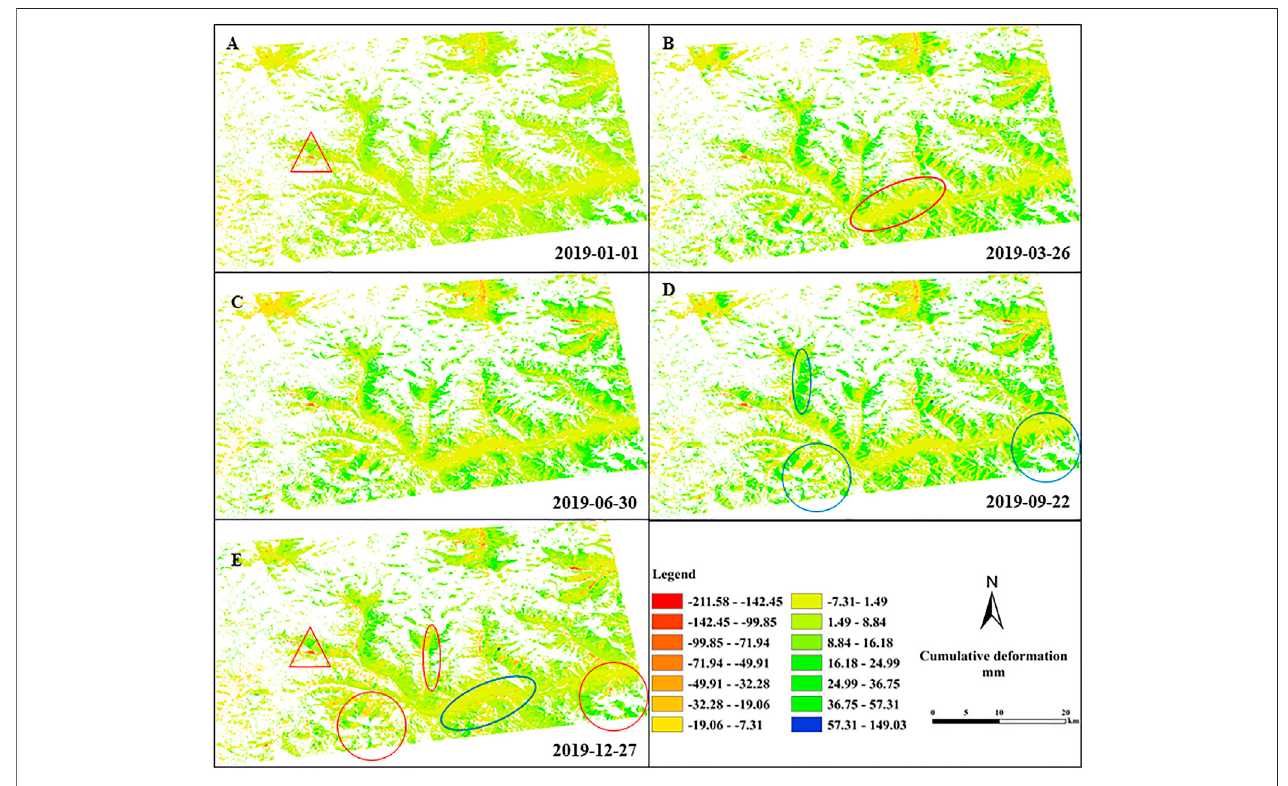
FIGURE 6 | Cumulative deformation (mm) during 2019 [ (A – F) are the dates of 2019 – 01-01, 2019-03 – 26, 2019-06 – 30, 2019-09 – 22, and 2019-12 – 27, respectively]. Geometric labels indicate areas of signi fi cant change, with red indicating subsidence and blue indicating uplift.